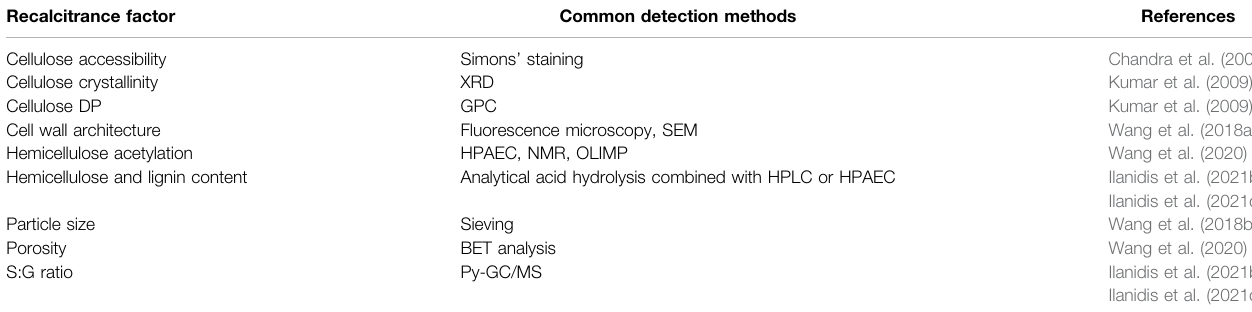
TABLE 3 | Factors affecting recalcitrance of lignocellulosic feedstocks, and common detection methods with references a